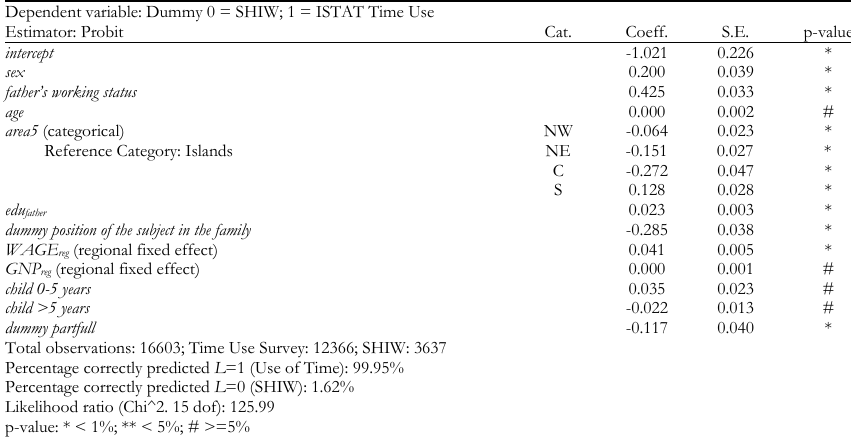
Matching procedure: Conditional propensity score